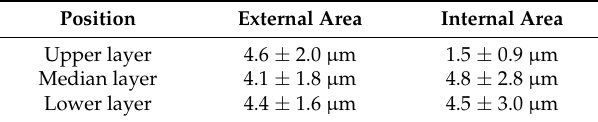
Table 4. Polymer layer thicknesses and standard deviations of cross-sections of PCL-coated titanium scaffolds ( n = 3 and each area with 6 measurements).